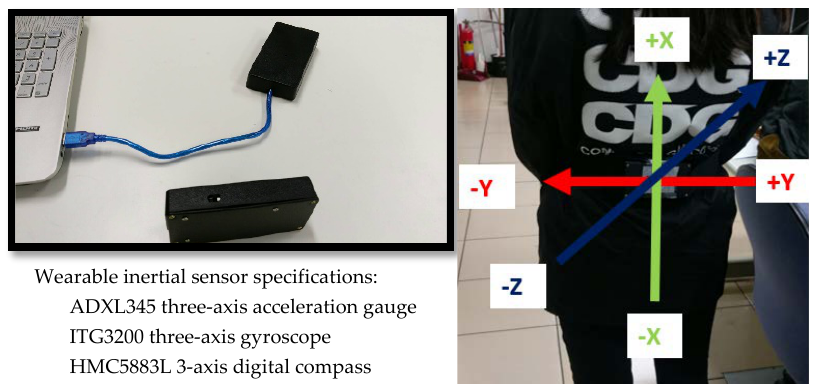
Figure 1. Schematic of the wearable sensor and triaxial.